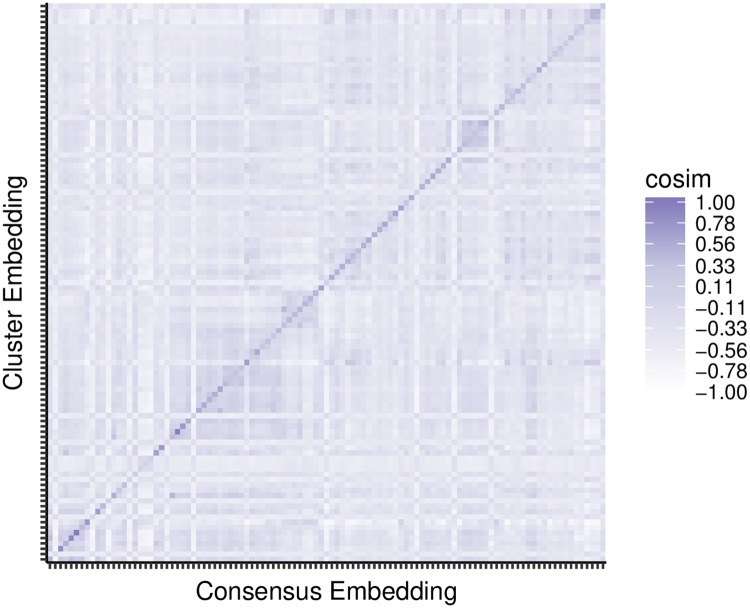
Agreement between consensus sequence embeddings and their cluster embeddings.For each cluster, all KEGG 16S sequences were embedded into a cluster embedding, and the cluster’s VSEARCH consensus sequence was embedded into a consensus embedding. The pairwise cosine similarities between all consensus and cluster embeddings are shown. They are sorted based on the (arbitrary) index for cluster membership. Darker shading indicates larger cosine similarity betweens cluster and consensus embeddings. Thus, the dark diagonal represents that the cluster embedding is similar to the consensus embedding for that cluster.